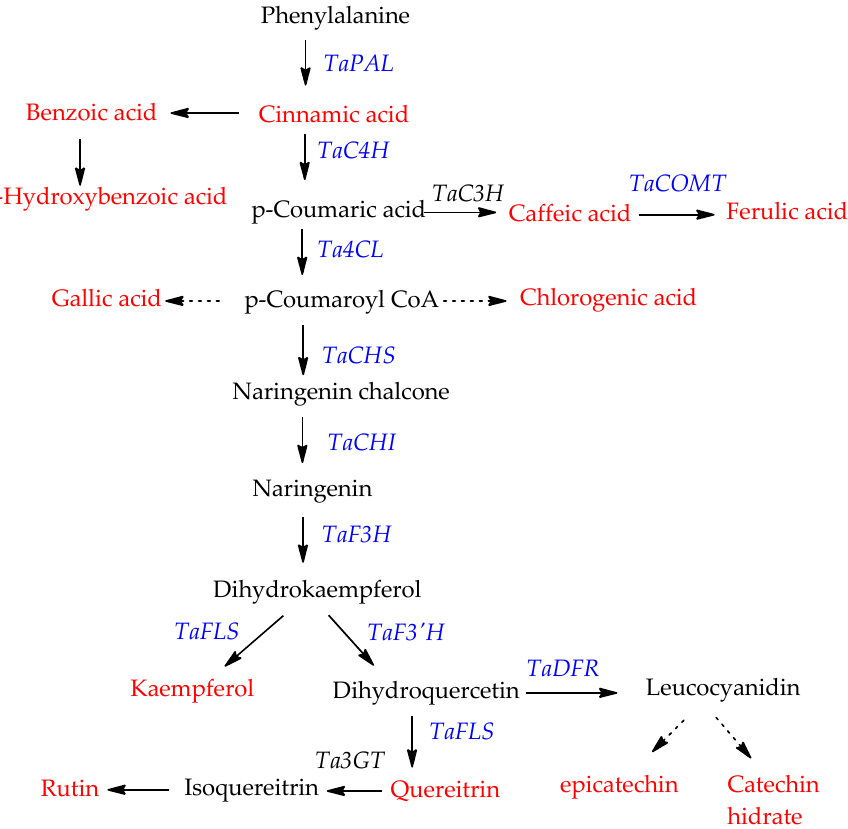
Figure 1. The phenylpropanoid biosynthetic pathway in wheat sprouts. A red color indicates the phenylpropanoids and flavonoids quantified in this study by HPLC. Blue indicates the enzymes whose gene expression was analyzed by using qRT-PCR. Abbreviations: PAL, phenylalanine